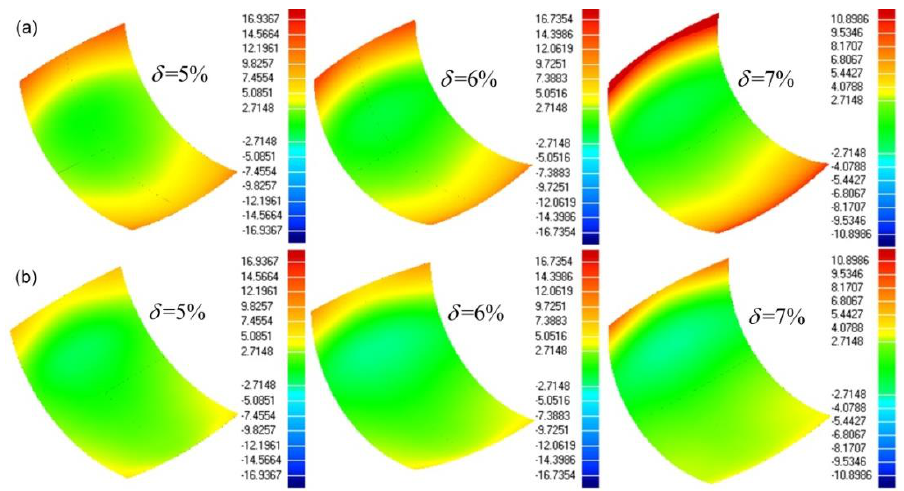
Figure 8. Error nephograms under different compression ratios ( δ ) of convex surfaces: (a) Before modification; (b) After modification.